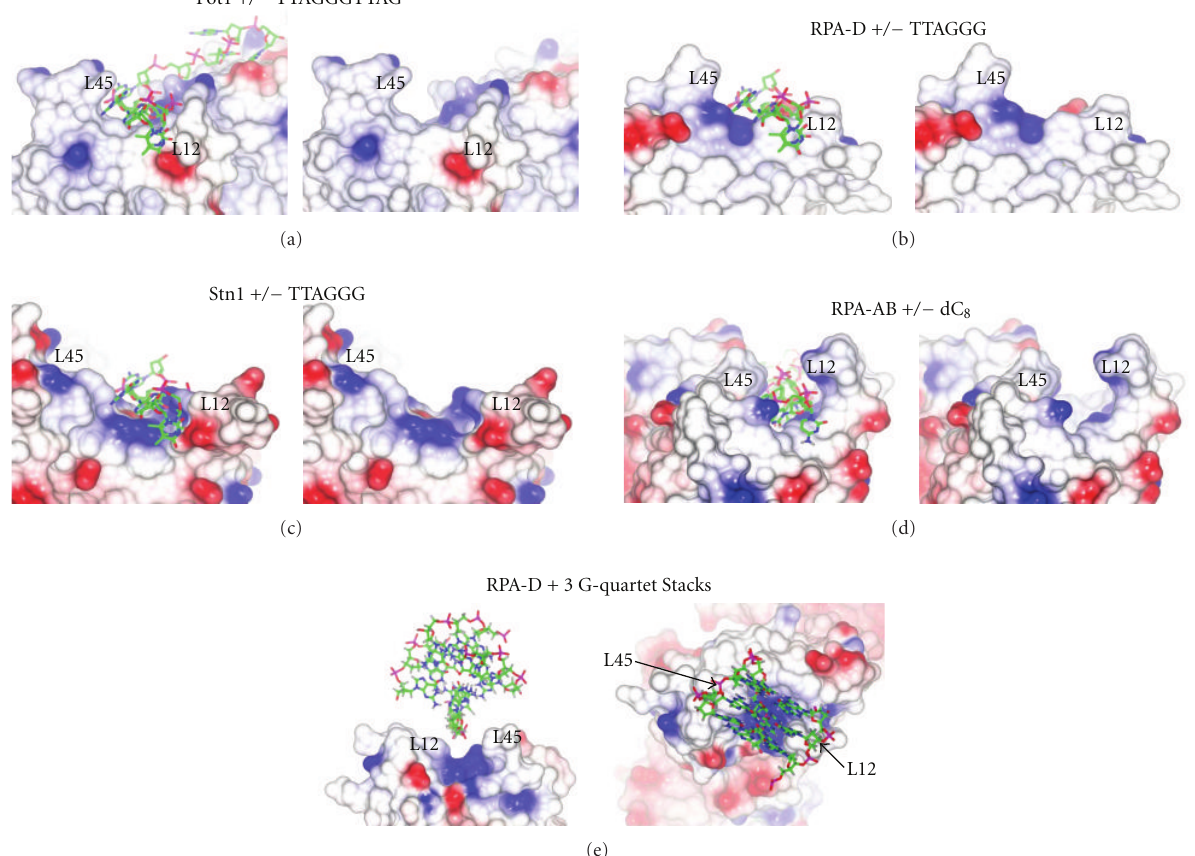
Figure 8: Electrostatic surface potential of the proteins (a) Pot1, (b) RPA-D, (c) Stn-1, and (d) RPA-AB are depicted with ssDNA (left) and without ssDNA (right). The ssDNA from the Pot1 crystal structure is shown here as a reference point to indicate the known/predicted binding site for the surfaces of Pot1, RPA-D, and Stn1. RPA-AB is shown with dC 8 bound (PDB 1JMC). (e) Left, side view of the surface electrostatic potential of RPA-D rotated 180 ◦ about Y relative to Figure 8, with an antiparallel G-quadruplex (PDB ID: 2E4I, trimmed to include only the 3 stacks of G-quartets) displayed in the potential binding groove formed between L12 and L45; right, top view. All the figures were created using ccp4mg with − 0.5 V (red) to +0.5 V (blue) [12]. For parts (b) and (e), the surface was calculated with PDB entry 1QUQ and included both RPA2 and RPA3 coordinates, but only RPA-D is